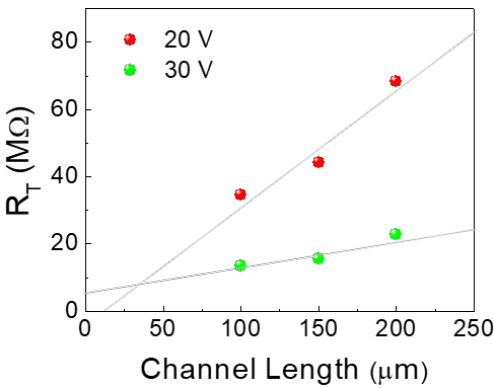
Figure 6. Total resistance vs. channel length (R T -L) plots obtained from IGO NW TFTs having channel lengths of 100~200 µm (V G = 20 V, 30 V).